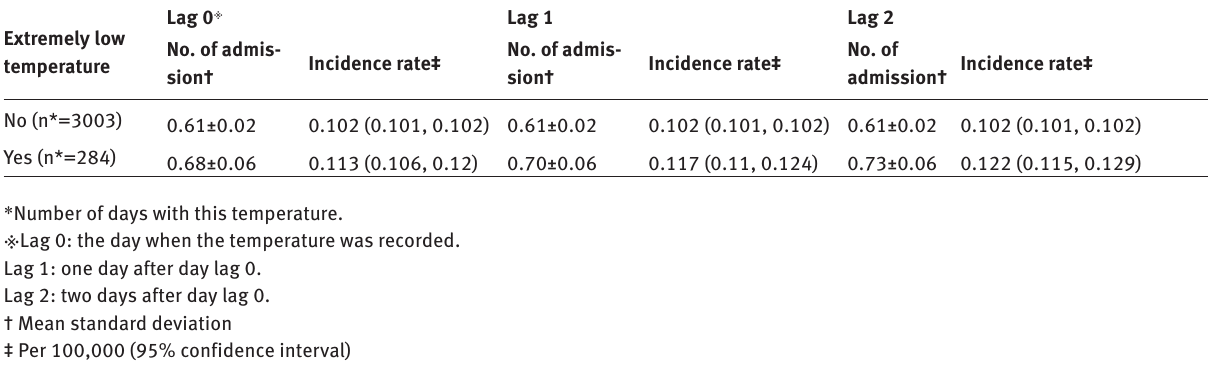
Table 3: Daily temperature range correlates with acute myocardial infarction (AMI) admission (n=2033 patients) Daily temperature range ( o C)